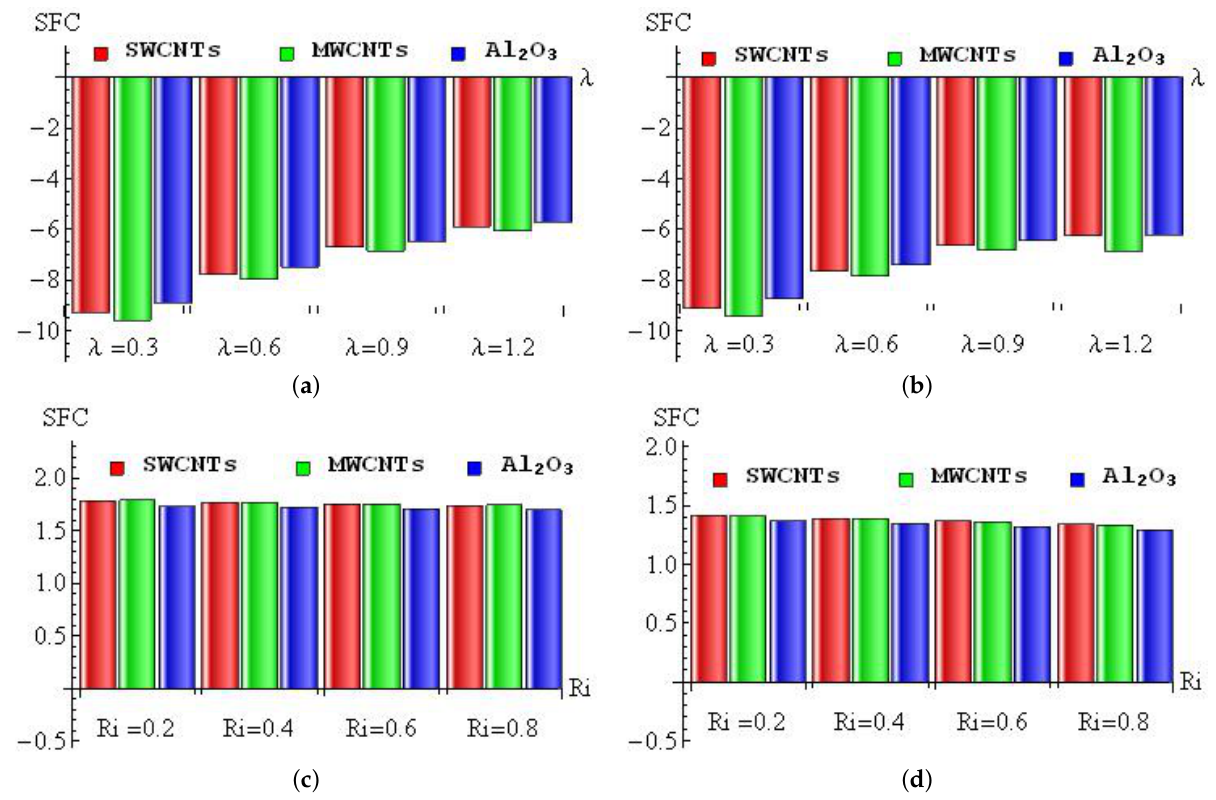
Figure 11. The diminishing/improving percentage of SFC for λ ( a , b ) and Ri ( c , d ) with convective heating ( a , c ) and convective cooling ( b , d ) cases.